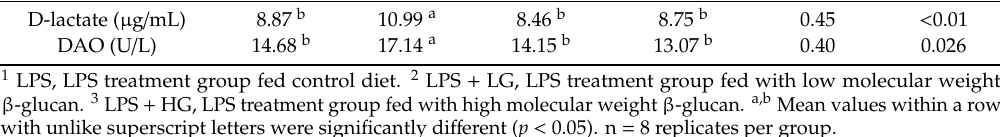
Table 8. Serum D-lactate and diamine oxidase (DAO) of piglets fed di ff erent molecular weight β -glucan.